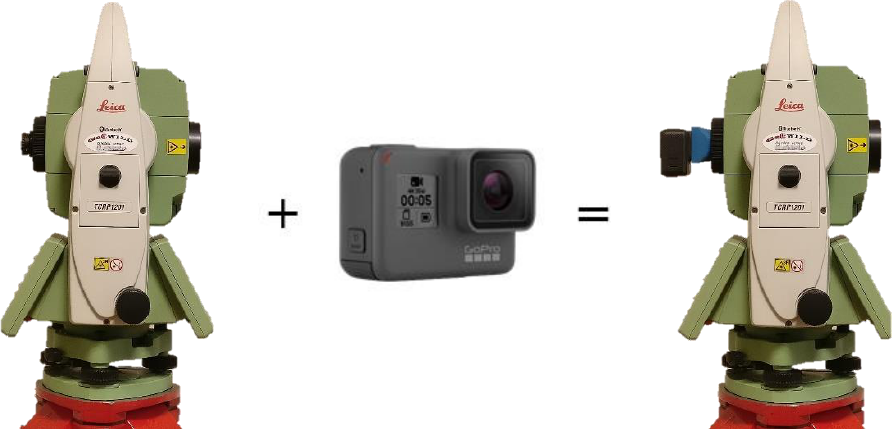
Figure 1. IATS prototype: Leica TPS1201 plus GoPro Hero5 camera.